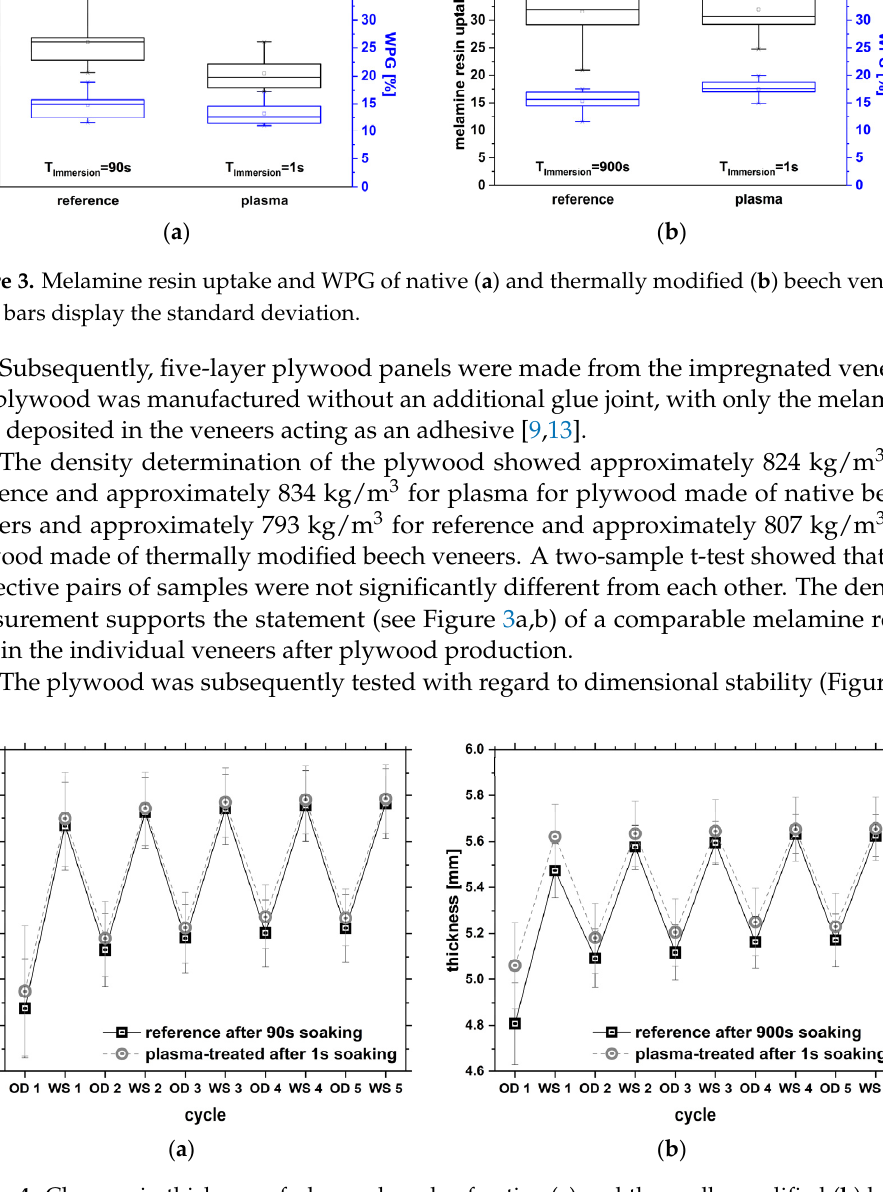
Figure 4. Changes in thickness of plywood made of native ( a ) and thermally modified ( b ) beech veneers in relation to series of cycles for determining dimensional stability. Error bars display the standard deviation.